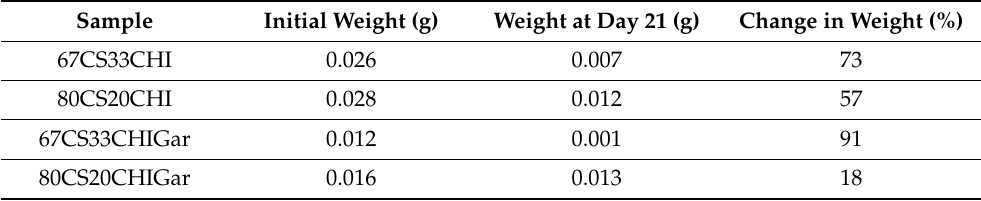
Table 2. Change in the weight of the hydrogels after 21 days in